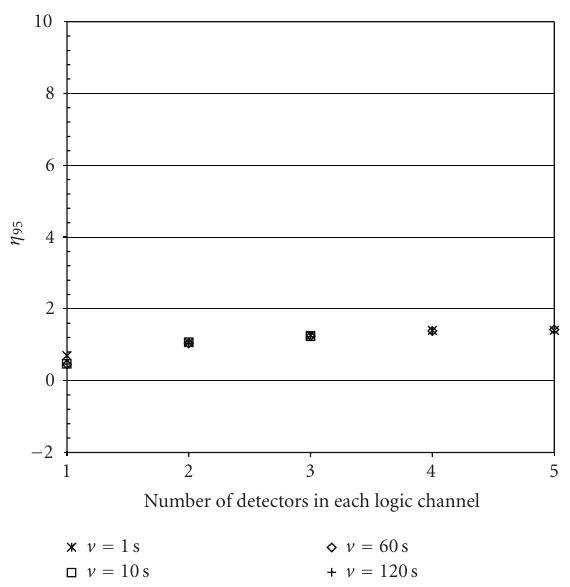
Figure 5: Allowance factor behavior as a function of the number of detectors in each logic channel and as a function of transient